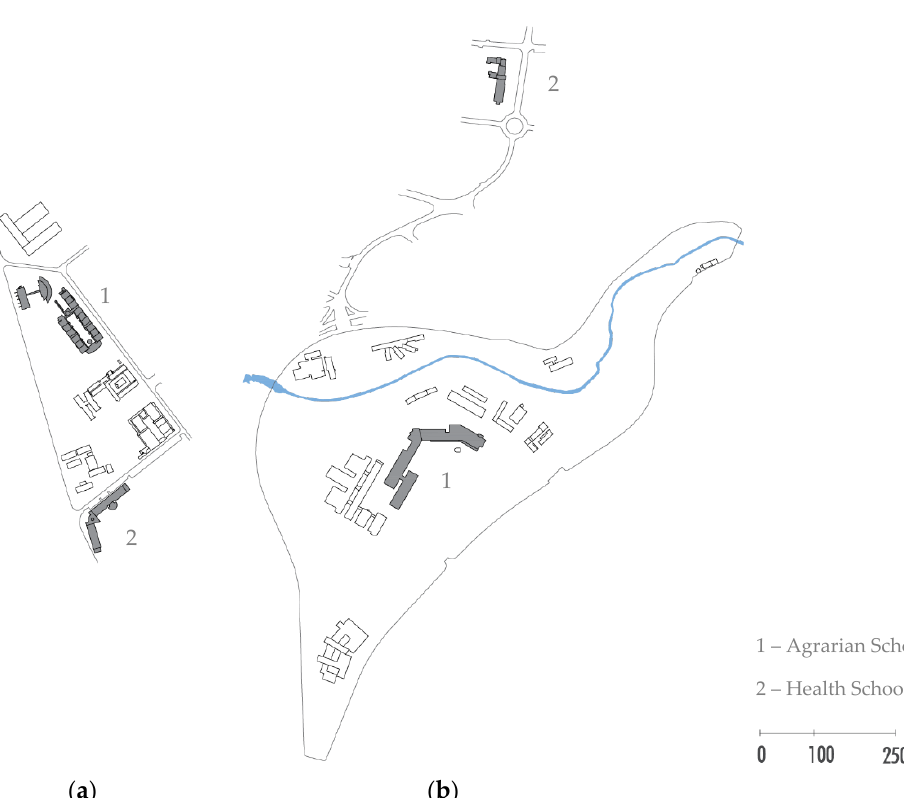
Figure 5. Precincts of the Polytechnics Institutes: ( a ) Beja; ( b ) Bragança.